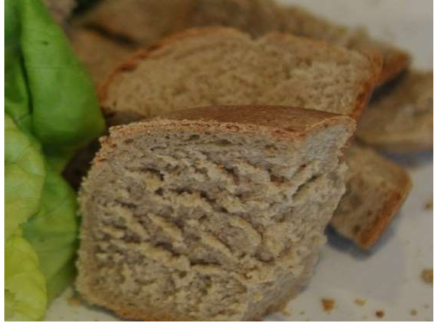
Figure 3. Piece of bread with insect powder